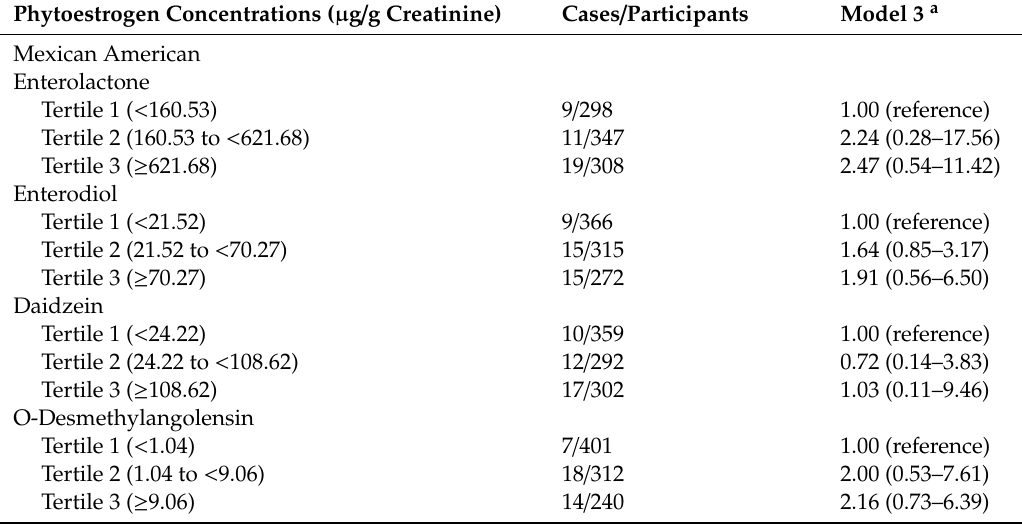
Table 6. Weighted odds ratios (95% confidence intervals) for sleep disorders across tertiles of